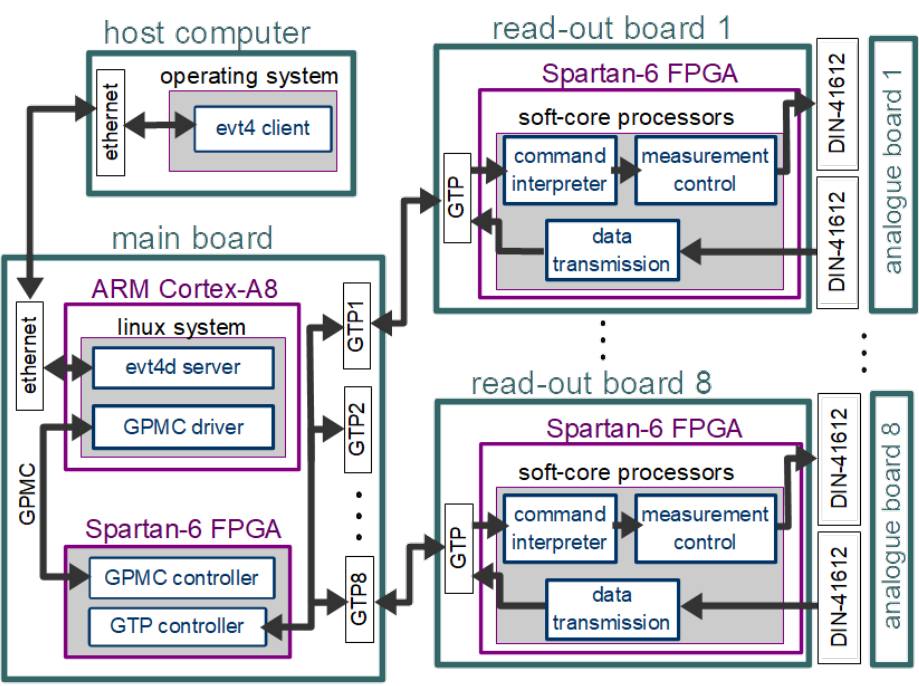
Figure 1. Software architecture of EVT4 capacitance tomography system.